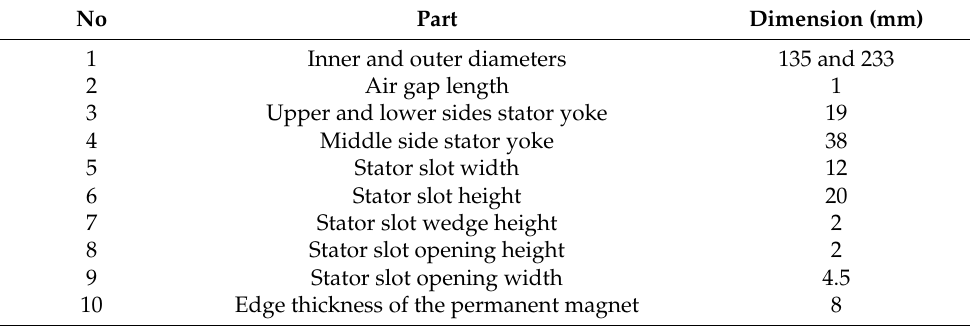
Table 1. Dimensions of the proposed